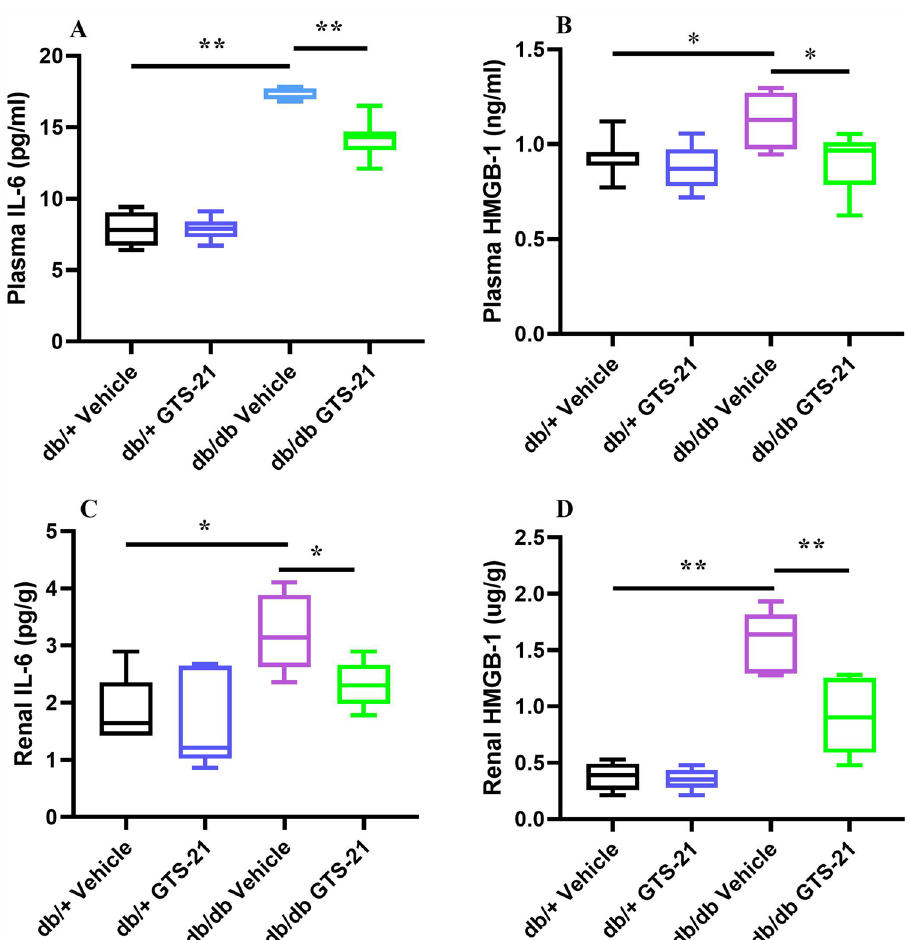
Figure 2. Effects of GTS-21 on inflammatory markers (IL-6 and HMGB-1). All mice received GTS-21 (4 mg/ kg, IP, B.I.D.) or vehicle for 8 weeks. The plasma and protein from kidney were collected for measuring